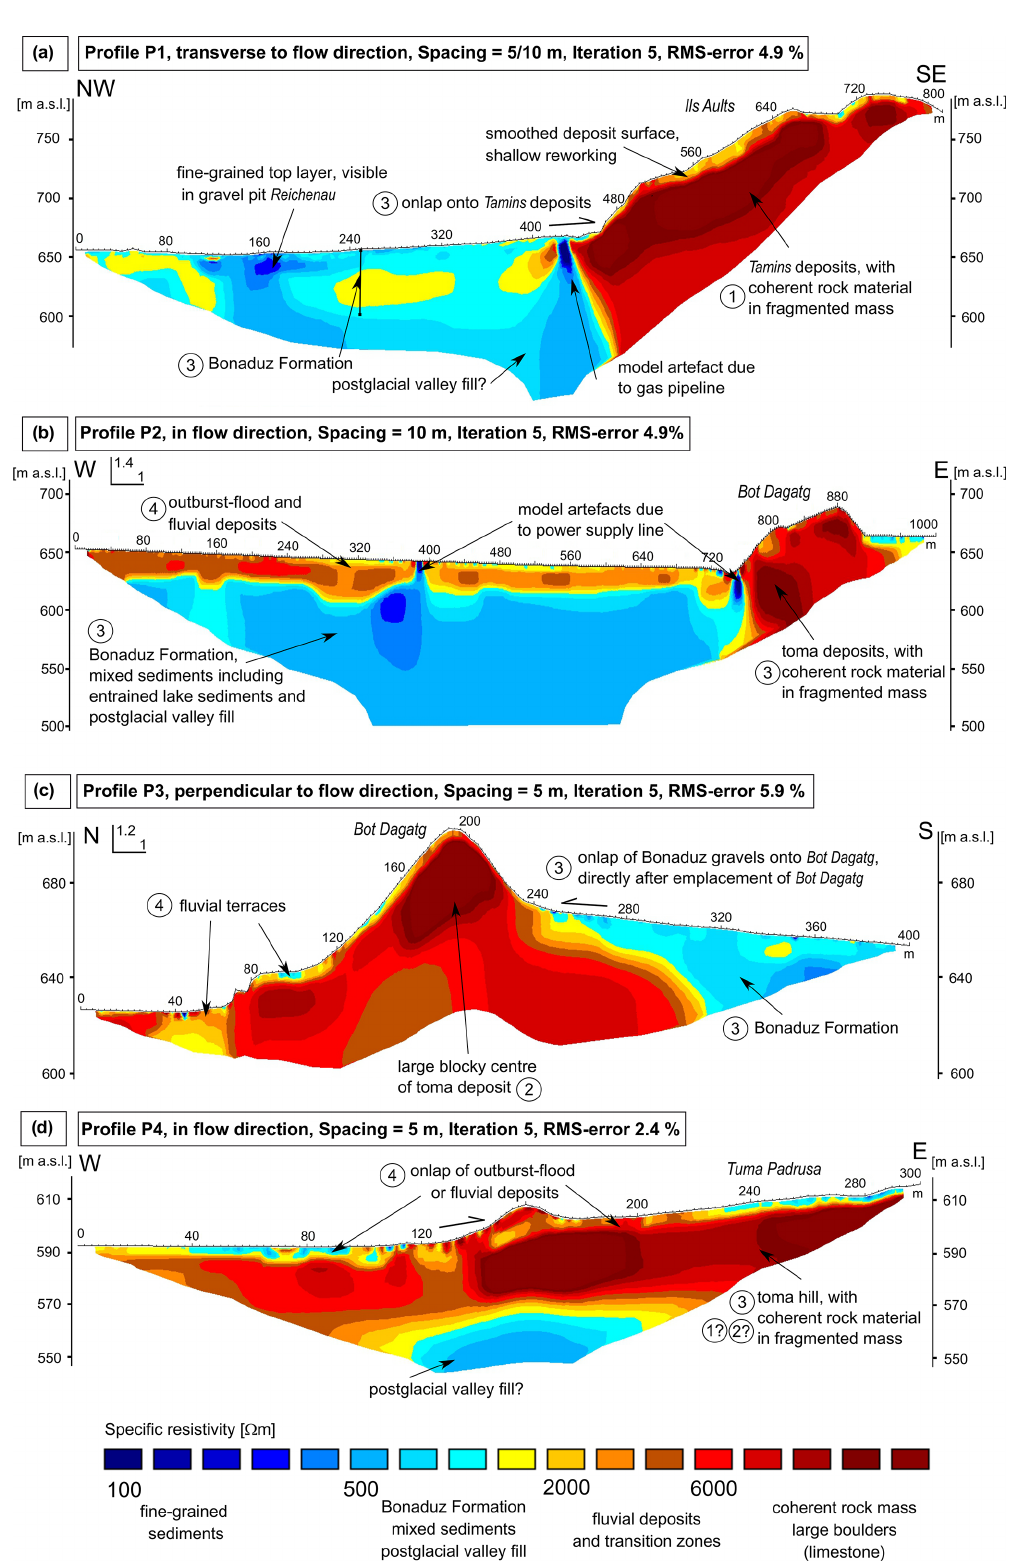
Figure 4. ERT profiles P1–P4 indicating (a) the ∼ 60m thick Bonaduz Formation (Phase 3) onlapping onto Ils Aults (Phase 1), (b) Bot Dagatg transported within the Bonaduz Formation (Phase 3), covered with some outburst-flood and/or fluvial deposits (Phase 4), (c) the onlapping Bonaduz Formation onto Bot Dagatg, and (d) Tuma Padrusa containing large slabs of (exposed) coherent rock material in a fragmented rock mass. The circled numbers correspond to the evolution phases 1–4. https://doi.org/10.5194/esurf-10-1185-2022 Earth Surf. Dynam., 10, 1185–1193,